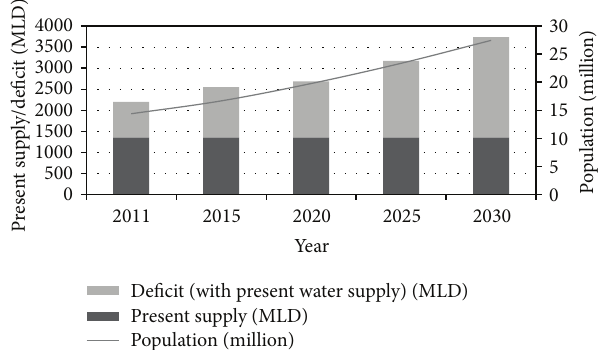
Figure 4: Present water supply, shortage, and population variation for projected years.